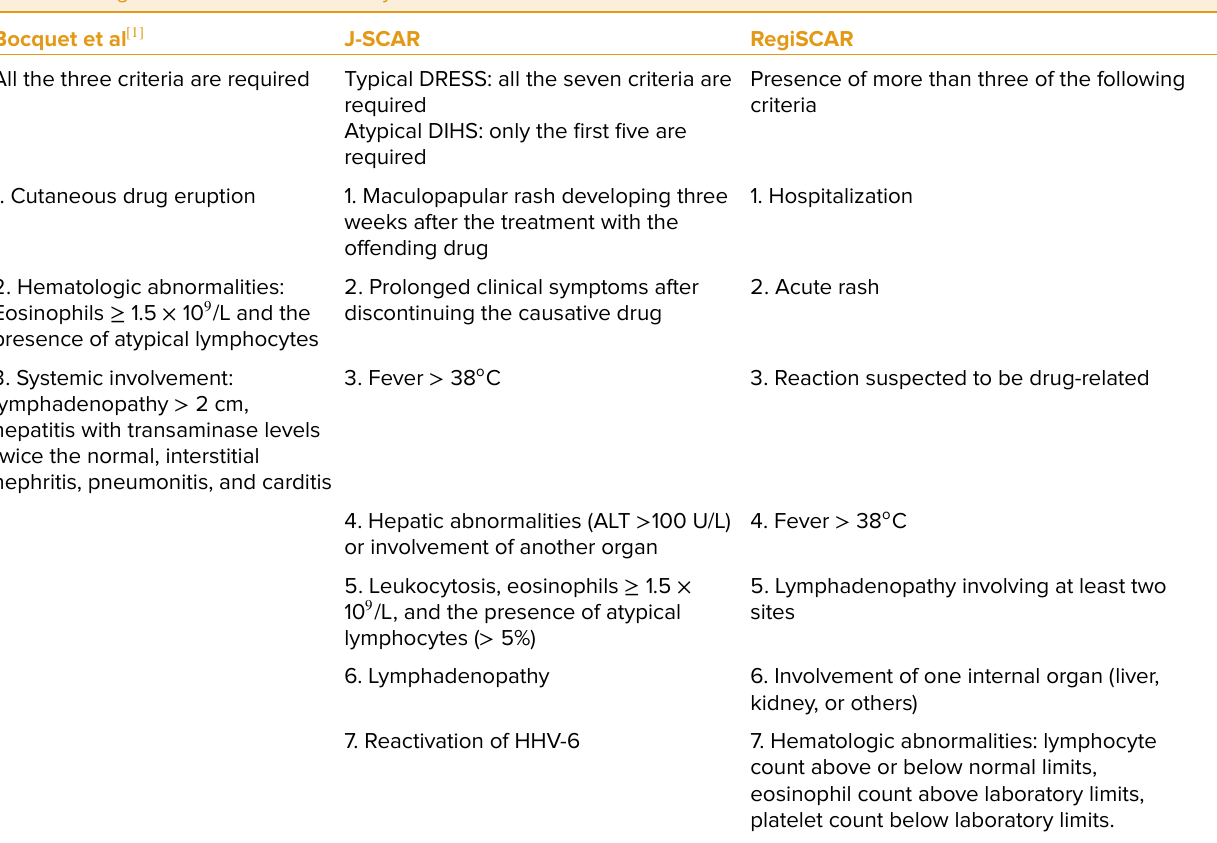
Table 1. Diagnostic criteria for DRESS